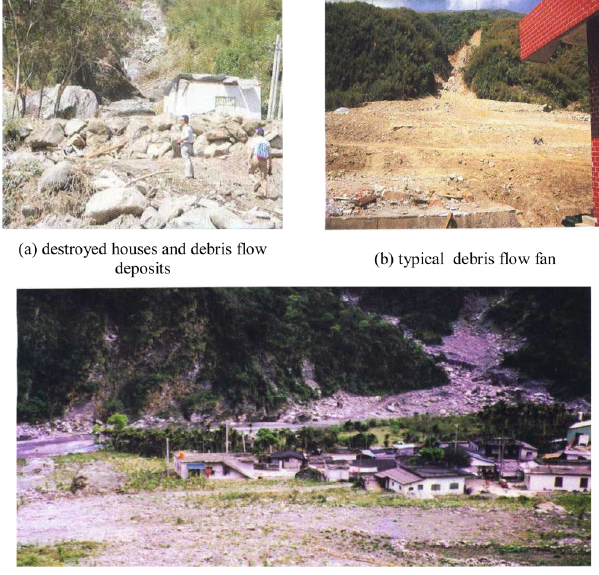
Fig. 2. Landslide and debris flow disaster caused by Typhoon Ofelia occurring on 22 June 1990 in Tongmen Village. Figure 3. A holistic framework for sediment yield estimate in hilly watershed. 600